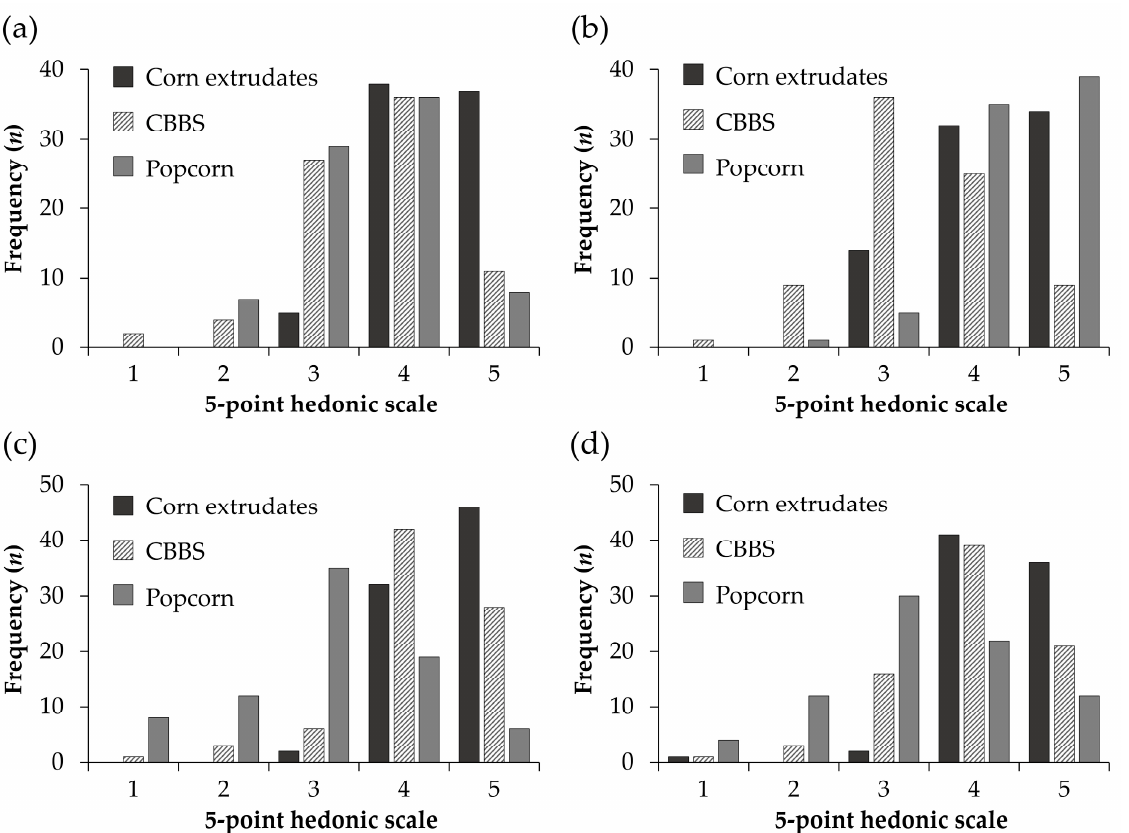
Figure 3. Frequency distribution of sensory evaluation outcomes of the common bean baked snack (CBBS), ACT II ® naturally flavored popcorn and crunchy Cheetos ® . ( a ) Overall acceptance; ( b ) appearance; ( c ) crispness; ( d ) hardness.